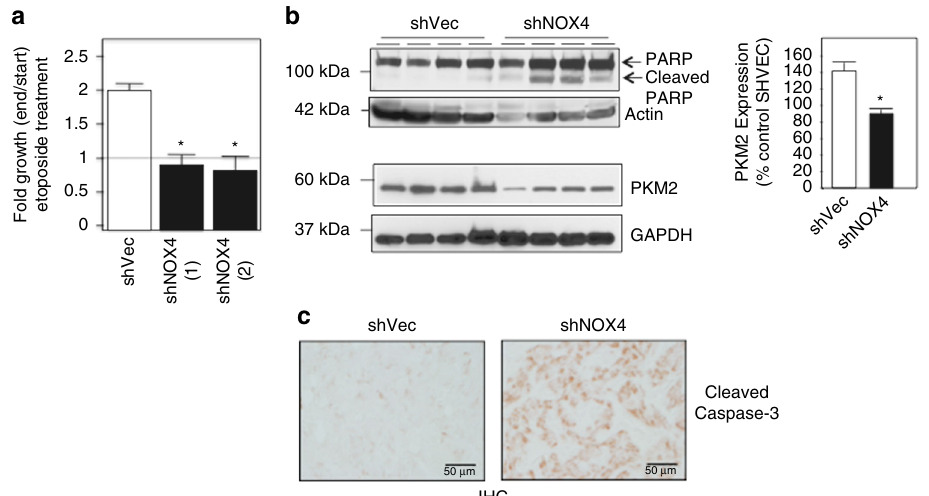
Fig. 7 NOX4 inhibition sensitizes RCC cells to drug-induced cell death in vivo xenograft animal models. a Xenograft nude mouse model. shVector or shNOX4 cells were injected into the right and left fl anks, respectively, of the same nude mouse. After 5 weeks of growth, etoposide was delivered IP for four consecutive days. Tumor volume was measured using calipers prior to the fi rst etoposide injection and 4 days following the last etoposide injection. The results are from 10-independent mice for each independent shNOX4 clone 1,2 and fold growth (end measurement/start measurement) is expressed as the means using one-way ANOVA with Tukey ’ s post hoc test where ± S.E.M. * p < 0.05 is compared to shVector. b Tumors, from shVector and shNOX4 injections were removed from nude mice and lysates prepared. Total and cleaved PARP (upper panel) or PKM2 expression (lower panel) was examined by western blot analysis. Actin and GAPDH were probed as loading controls, respectively. Quantitation of b (left lower panel) expressed as the means using one-way ANOVA with Tukey ’ s post hoc test where ± S.E.M. * p < 0.05 is compared to shVector. c Cleaved caspase-3 was examined by immunohistochemical (IHC) analysis in tumors isolated from shVector and shNOX4 xenograft mice exposed to etoposide. Microscopy (×10) of the representative images. Scale bar: 50 μ